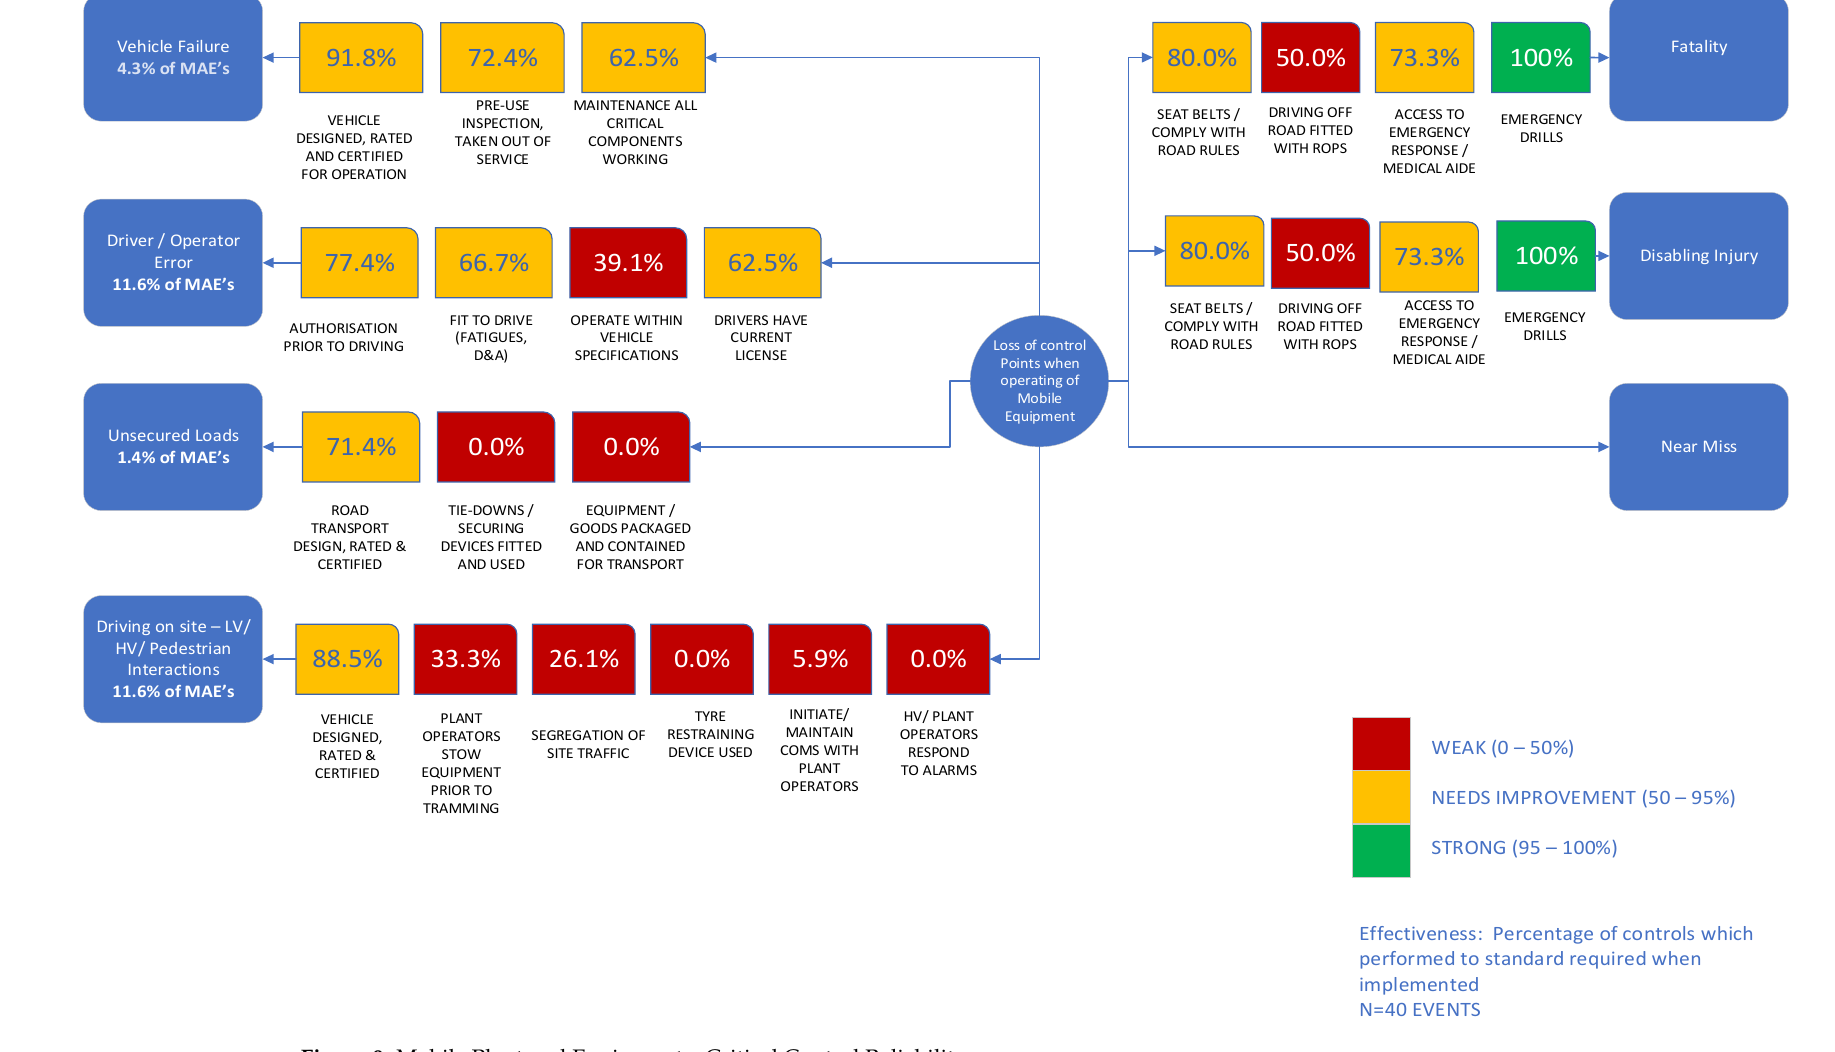
Figure 9. Mobile Plant and Equipment—Critical Control Reliability.